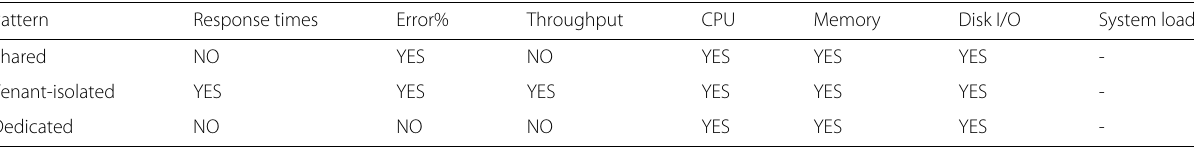
Table 5 Paired Sample Test Analysis for Case Study 3